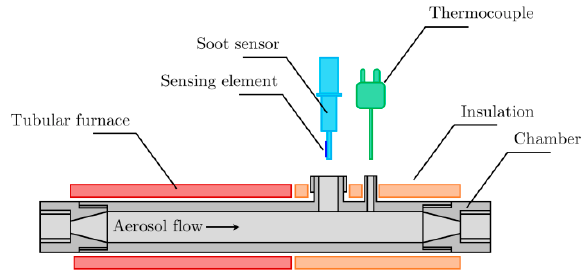
Figure 2. Illustration of the soot sensor chamber.